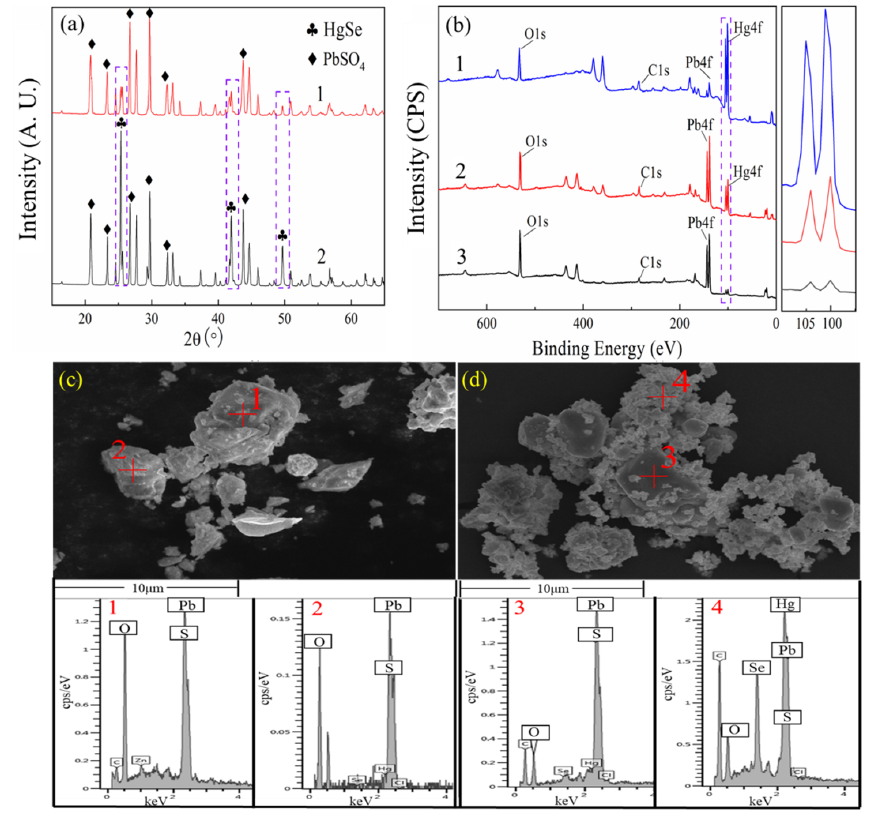
Figure 9. ( a ) XRD results of MAM by ( a 1) microwave heating at 400 °C and ( a 2) conventional heating at 500 °C; ( b ) The high-resolution XPS survey spectra of MAM: ( b 1) untreated MAM, ( b 2)